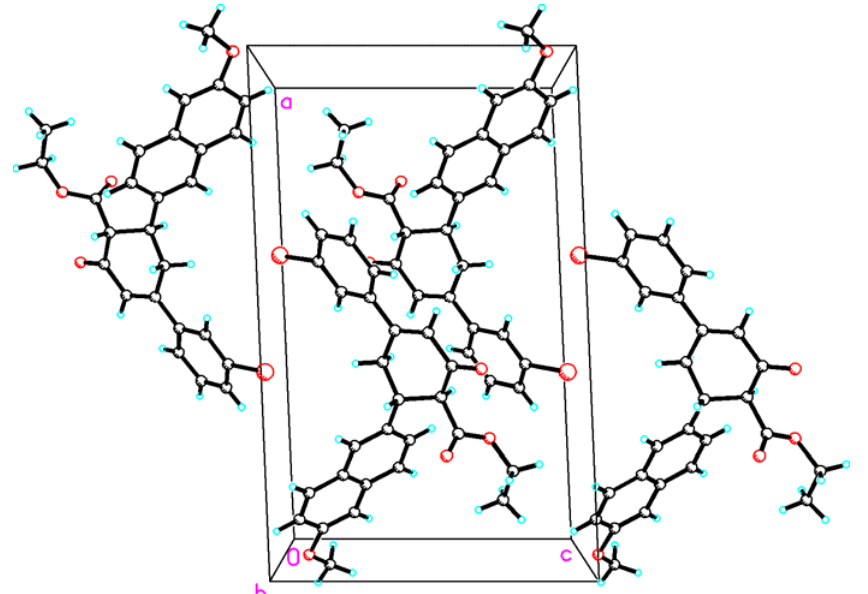
Figure 5. Packing diagram of ( II ) viewed along the a